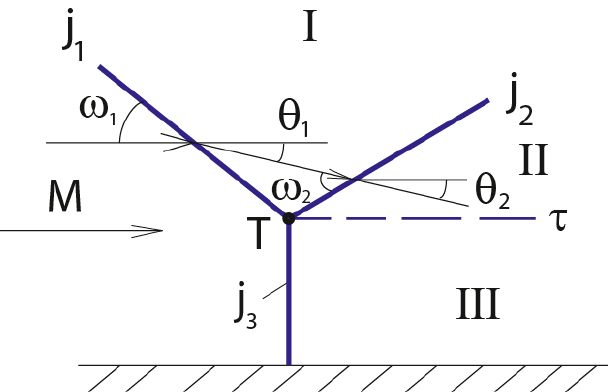
Figure 1. The stationary Mach configuration. Here, M is flow Mach number; j 1 is the incident shock; j 2 is the reflected shock; j 3 is the main shock (Mach stem); I, II and III are the flow regions downstream the corresponding shocks; T is the triple point; τ is the slipstream; ω 1 and ω 2 are shock slope angles; θ 1 and θ 2 are flow deflection angles on the incident shock and on the reflected